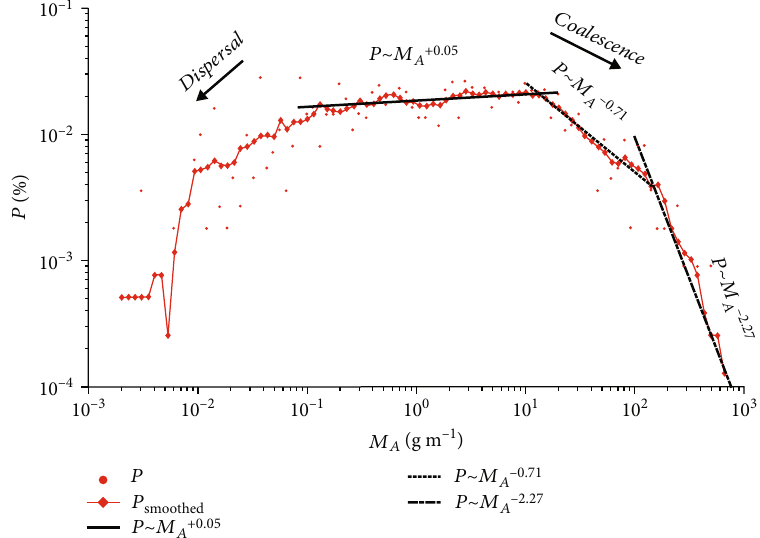
P ), and least-squares linear regression analysis